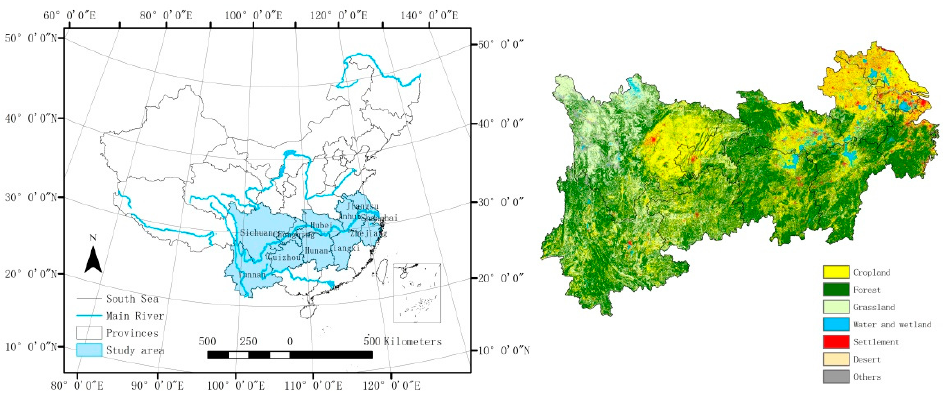
Figure 1. The geographical location and ecological pattern of the YREB of